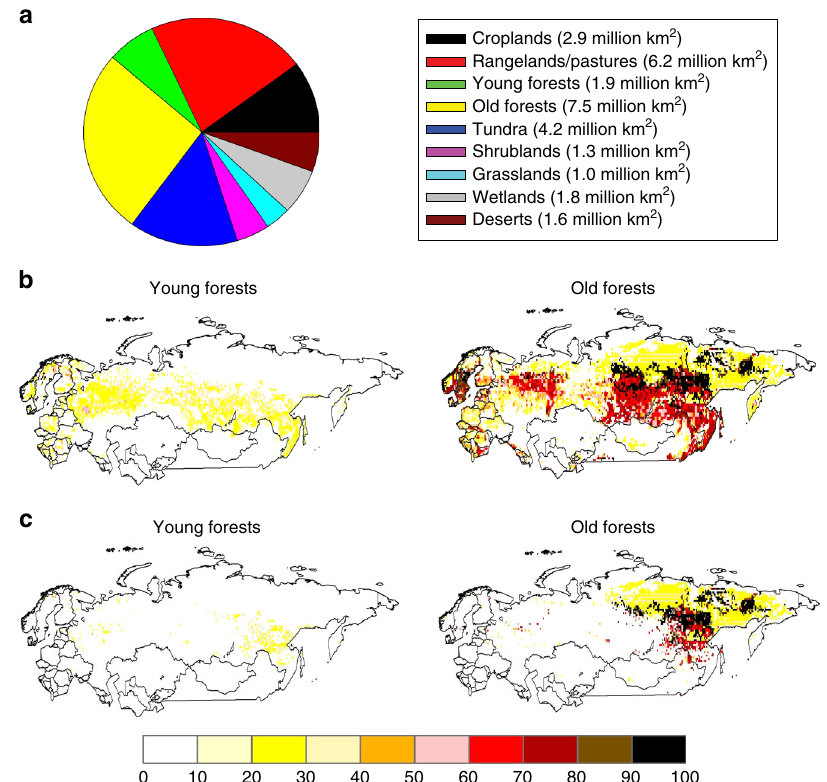
Fig. 1 Land cover characteristics of Northern Eurasia. a Pie chart of the relative areas of land cover in the study area during the year 2000. b Percent cover of all young (stand age <120-years-old) and old (stand age at least 120-years-old) forests during the year 2000. c Percent cover of young and old forests underlain by permafrost during the year 2000. The spatial distributions of other land cover types represented in the pie chart are given in Supplementary Fig.